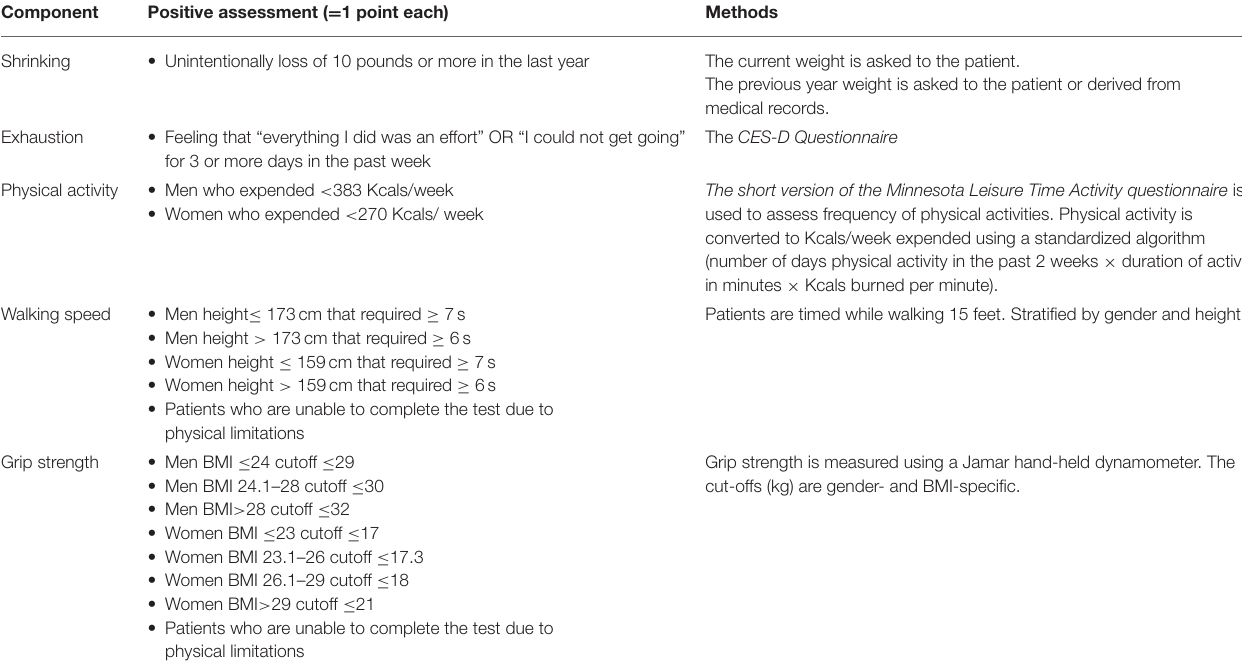
TABLE 1 | Measurement and Definition of Frailty Components using the Fried criteria (45).